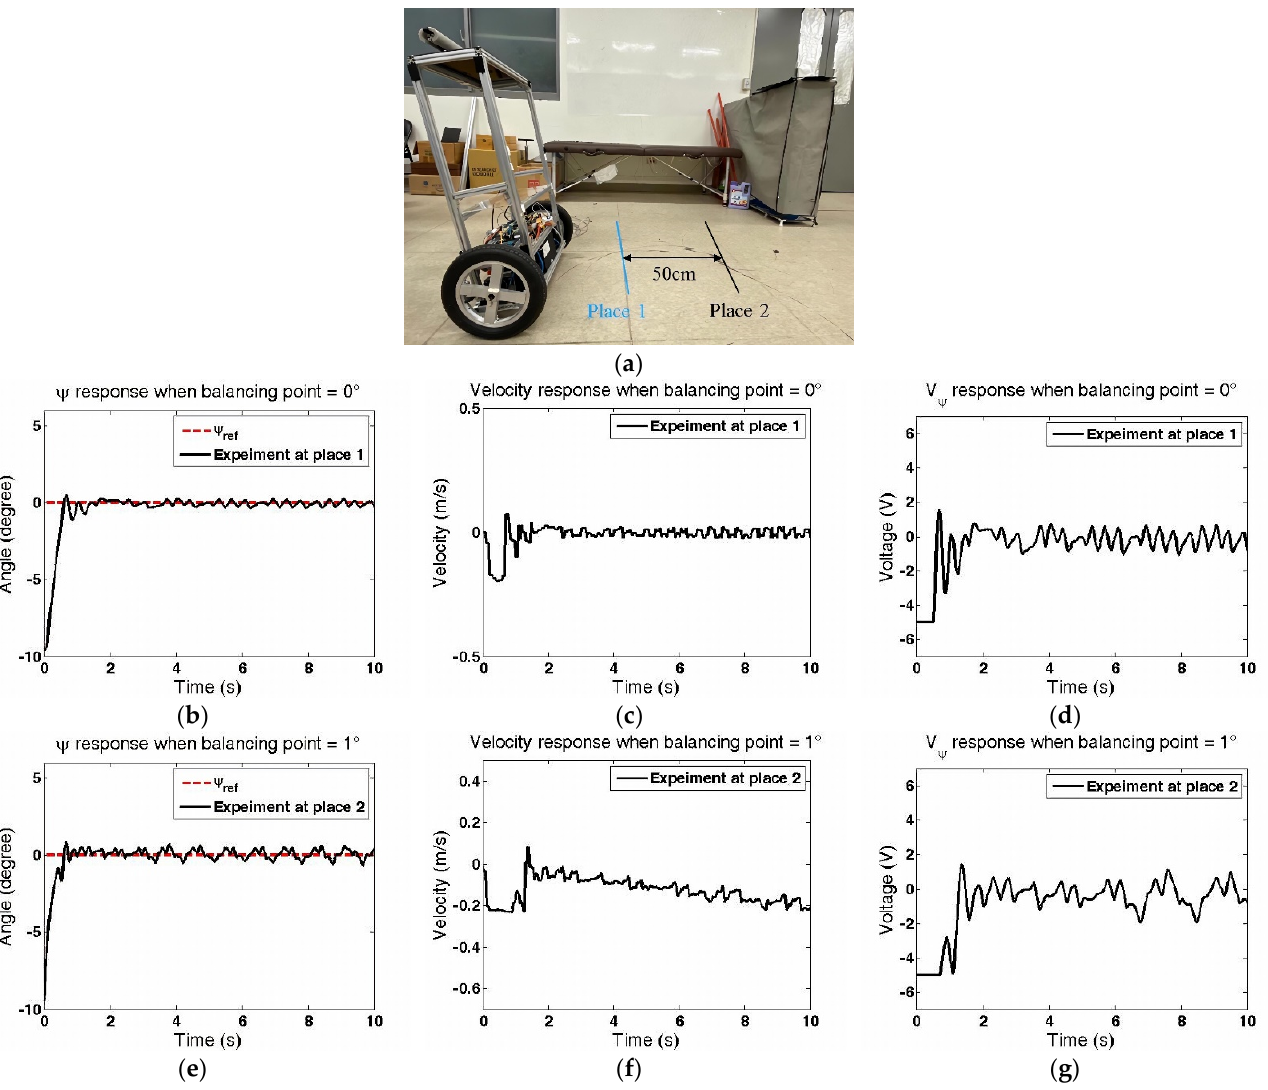
Figure 5. The experimental responses using the balancing loop control with 0    response at place 1; ( c ) Velocity response at place 1; ( d ) control signal V ψ ( t ) at place 1; ( e ) ψ ( t ) response at place 2; ( f ) Velocity response at place 2; ( g ) control signal V ψ ( t ) at place